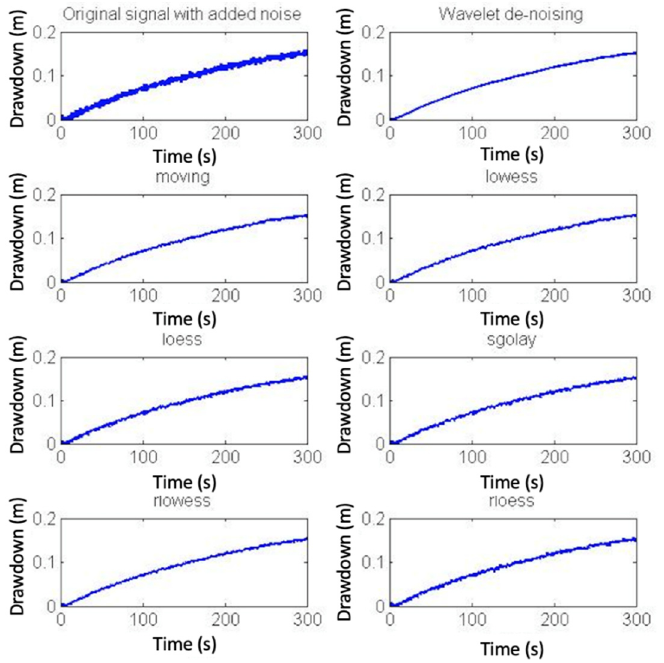
Figure 11. Comparison of original drawdown signal with added noise and de-noising results by using wavelet and other filters.